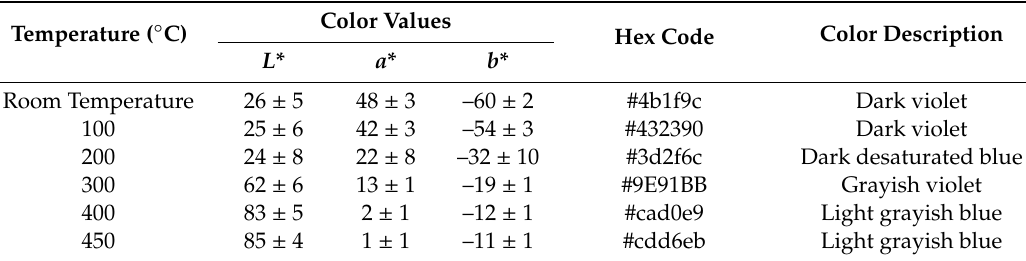
Figure 11. Color changes on the coating surfaces obtained in L * a * b * values. Table 3. Coatings— L * a * b * color change values and their corresponding color charts.